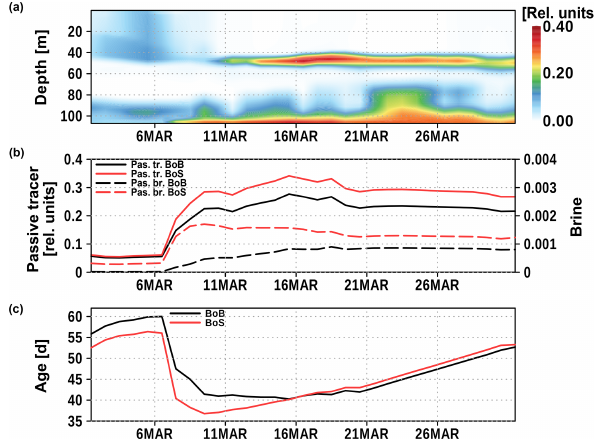
Figure 12. Model SST in the southern Bothnian Bay (black) and the northern Bothnian Sea